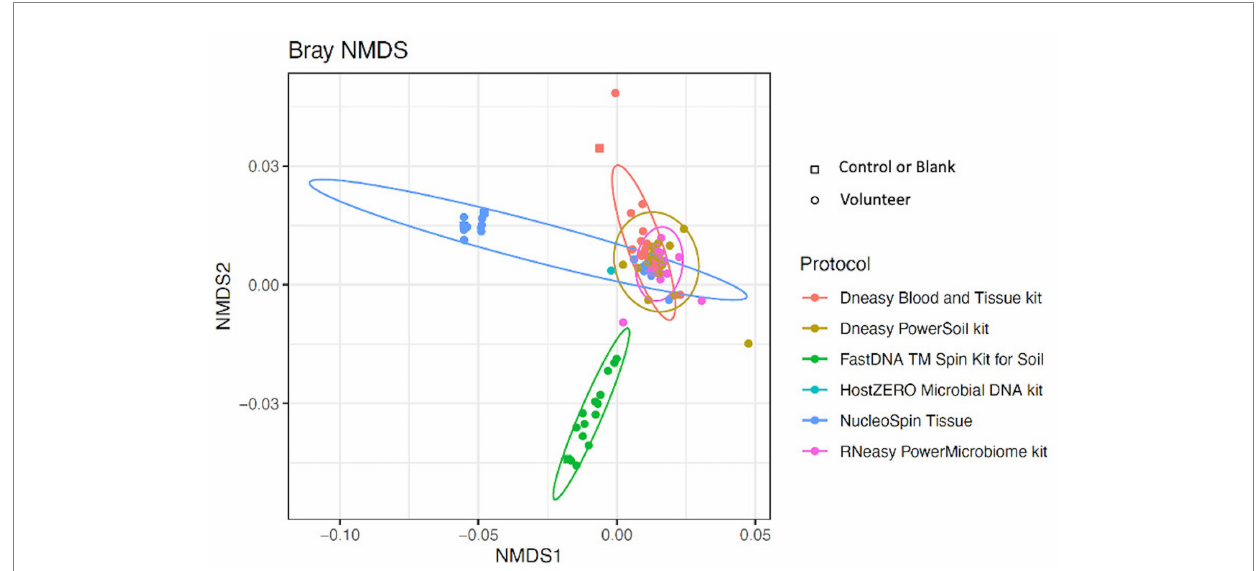
FIGURE 4 Bray-Curtis plot comparing different extraction protocols. Ordination diagram of nonmetric multidimensional scaling (NMDS), calculated based on the Bray–Curtis dissimilarity index showing clear microbial compositional differences dependent on the used extraction